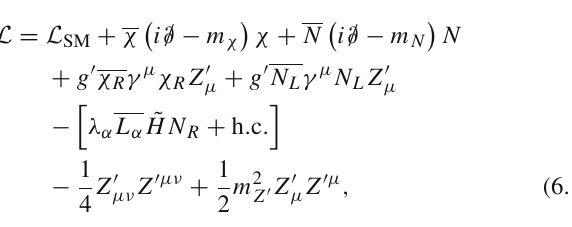
annihilation into neutrinos assuming the same set of model parame- ters. The right panel displays the indirect detection constraints coming from Planck and Fermi-LAT. The lower bound m χ (cid:3) 10 MeV is set by observations of the CMB and BBN. See text for further